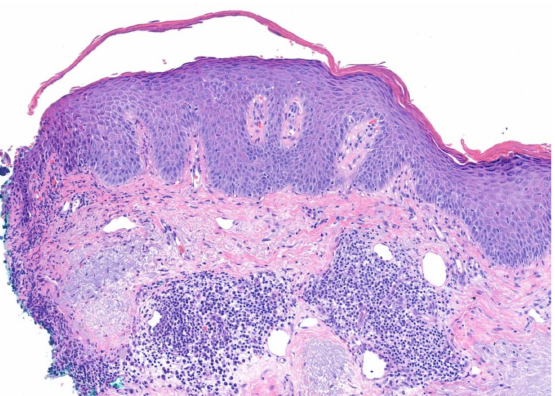
Figure 4. Pemphigus foliaceus. Superficial acantholysis within the granular